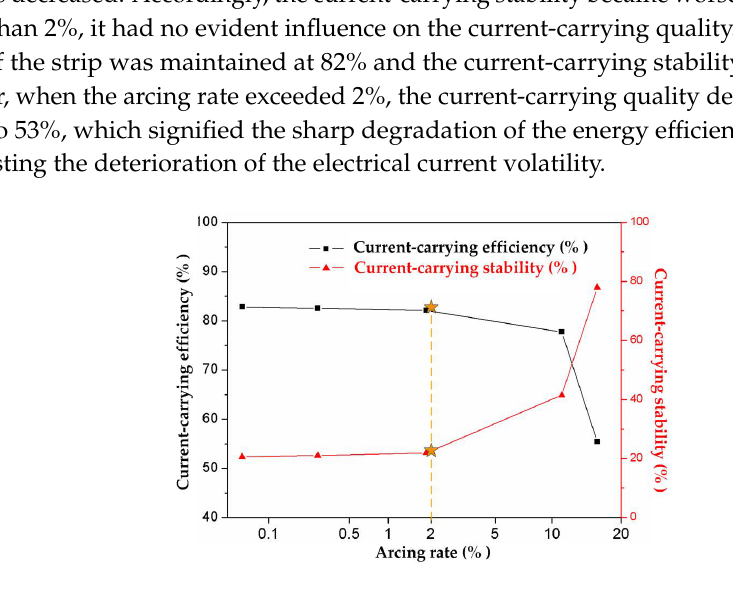
Figure 6. Current-carrying quality affected by arcing rate with the test parameters in Table 3.